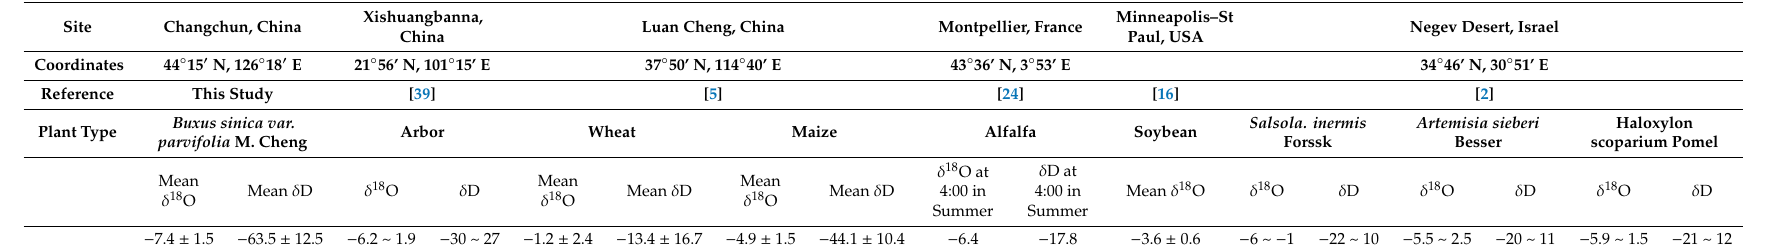
Figure 5. Trajectory map of air mass in typical rain events and d from June 2017 to September 2017. Table 1. Characteristic values of dew in di ff erent sites (% (cid:24)